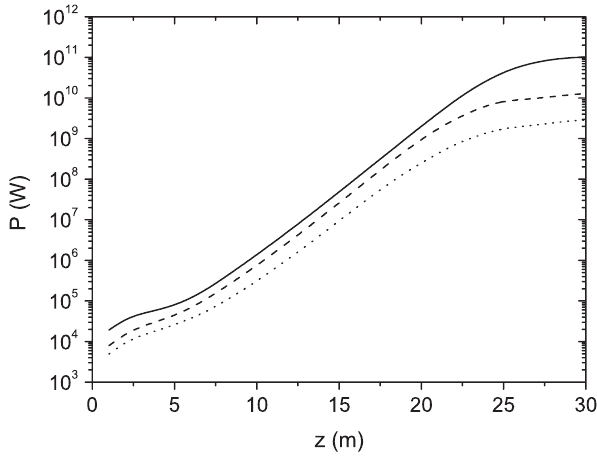
FIG. 6. An example for the European XFEL. Averaged peak power for the fundamental harmonic (solid), the third harmonic (dashed), and the fifth harmonic (dotted) versus undulator length for SASE3 operating at 4.5 nm. Parameters are in the text. Simulations were performed with the code FAST